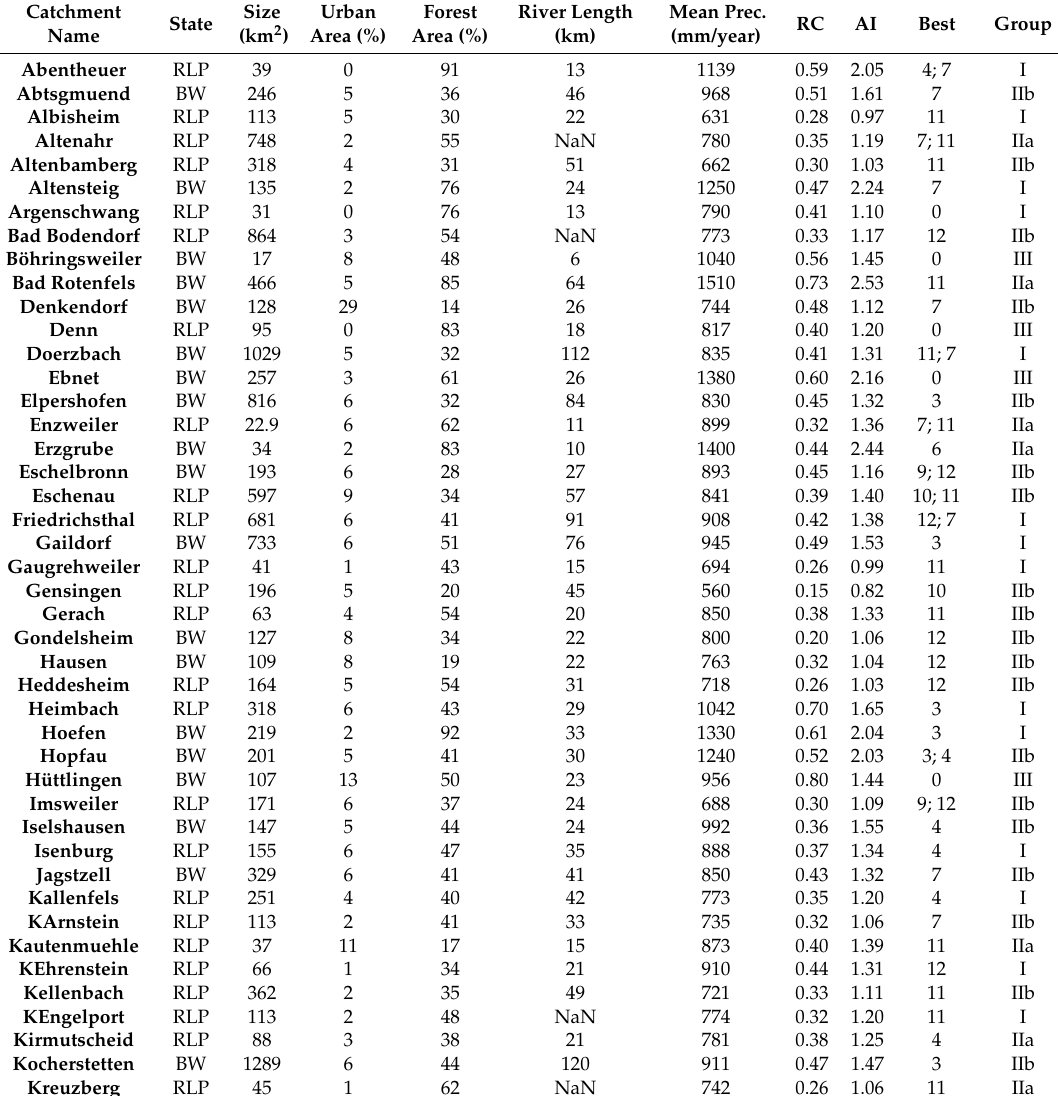
Table A1. Catchment